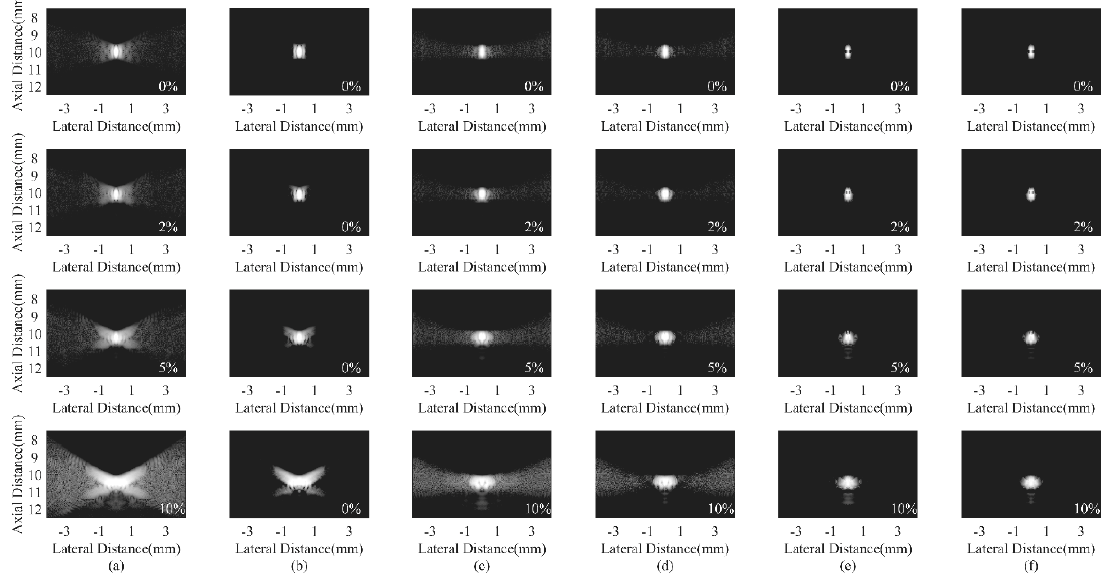
Figure 12. Simulated PSFs under different sound velocity errors using different beamformers: ( a ) DAS, ( b ) CF, ( c ) JTR-MV, ( d ) JTR-MV GCF, ( e ) JTR-ESBMV, ( f ) JTR-ESBMV GCF. The error rate is indicated in a white font in each image. All images are shown with a dynamic range of 60 dB.